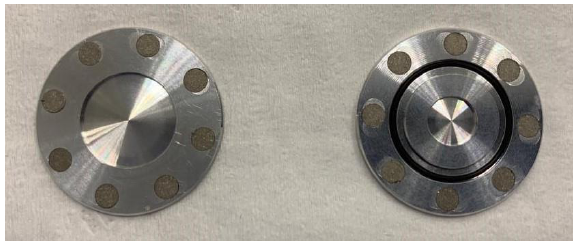
Fig. 1. The two halves of the coin target (24 mm diameter, 2 mm